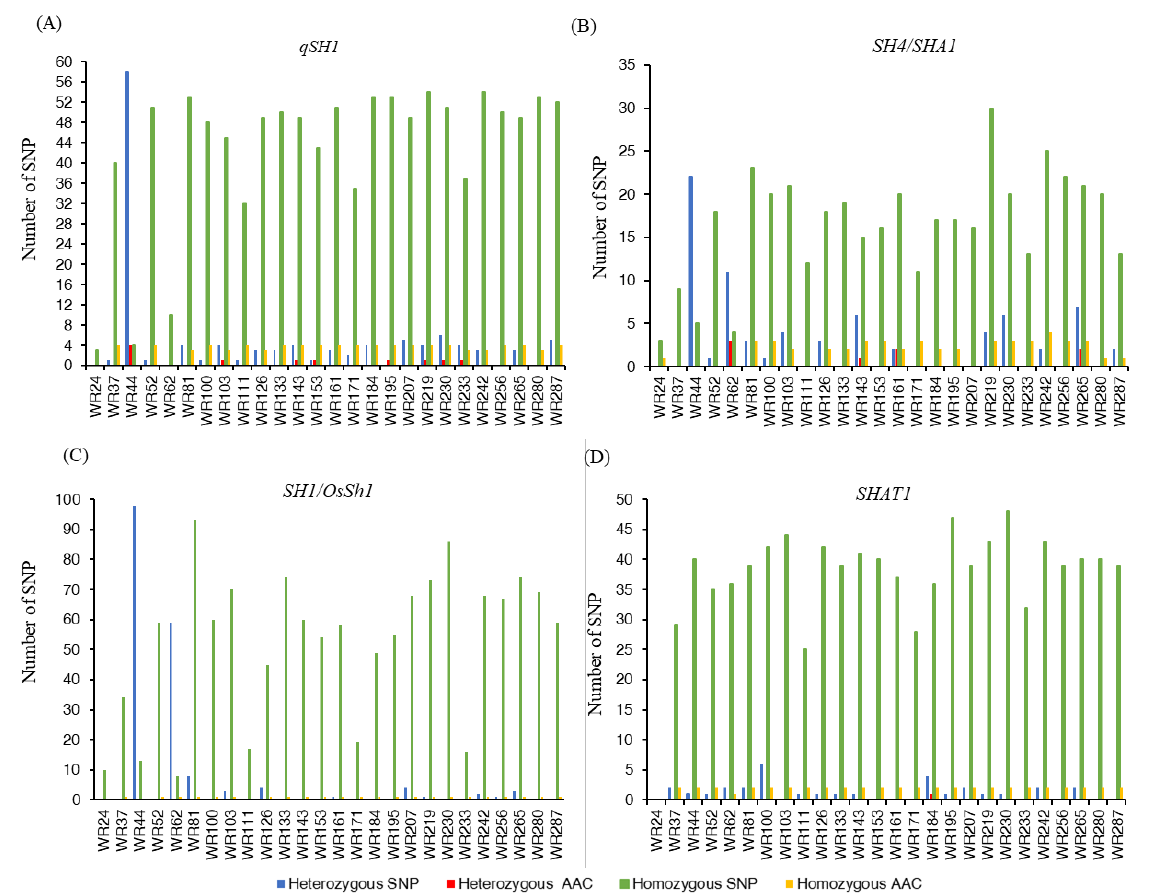
Figure 1. Variation of homozygous and heterozygous single nucleotide polymorphisms (SNPs) and corresponding amino acid changes (AAC) of four seed shattering loci in 26 Australian wild rice samples: ( A ) Total number of homozygous and heterozygous single nucleotide polymorphisms (SNPs) and corresponding amino acid changes (AAC) of qSH1 ( Shattering (QTL)-1 ); ( B ) Total number of homozygous and heterozygous single nucleotide polymorphisms (SNPs) and corresponding amino acid changes (AAC) of SH4 / SHA1 ( SHATTERING 4 ); ( C ) Total number of homozygous and heterozygous single nucleotide polymorphisms (SNPs) and corresponding amino acid changes (AAC) of SH1 / OsSh1 ( SHATTERING 1 ); ( D ) Total number of homozygous and heterozygous single nucleotide polymorphisms (SNPs) and corresponding amino acid changes (AAC) of SHAT1 ( SHATTERING ABORTION 1 ).